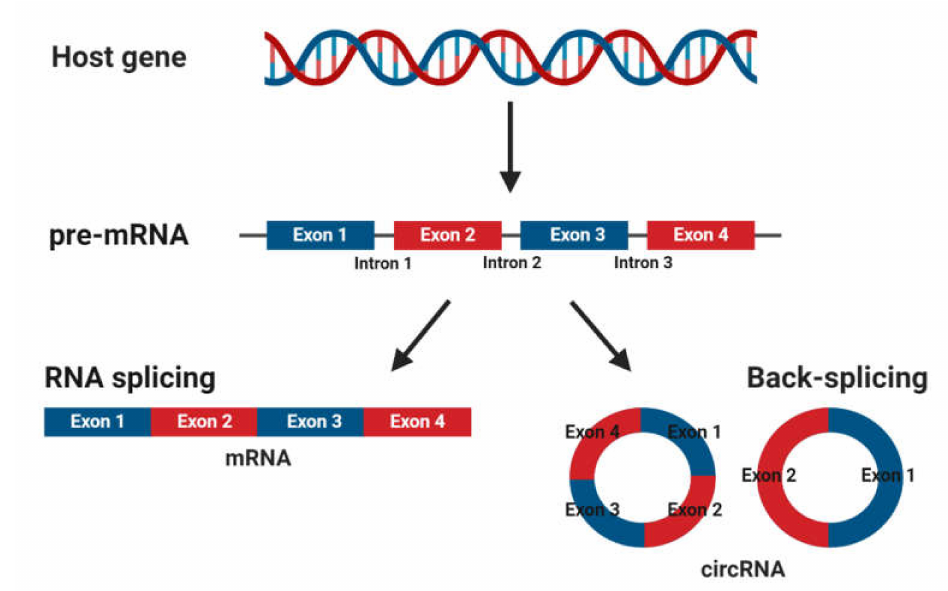
Figure 3. Biogenesis of mature messenger RNA (mRNA) and circular RNA (circRNA) from precursor mRNA (pre-mRNA). Pre-mRNA undergoes RNA splicing to form a mature mRNA or back-splicing to form circRNAs.